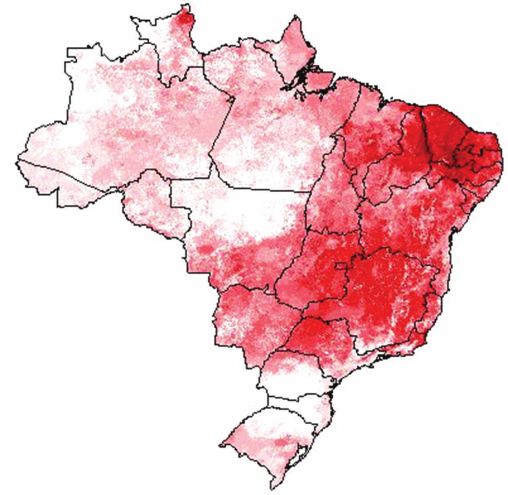
Figure 8: Triatomine species diversity map of Brazil, based on ecological niche models for 16 species of triatomine bugs. White areas have no species predicted as occurring, out of the 16 included in this analysis, while the darkest red areas have 13 species predicting as